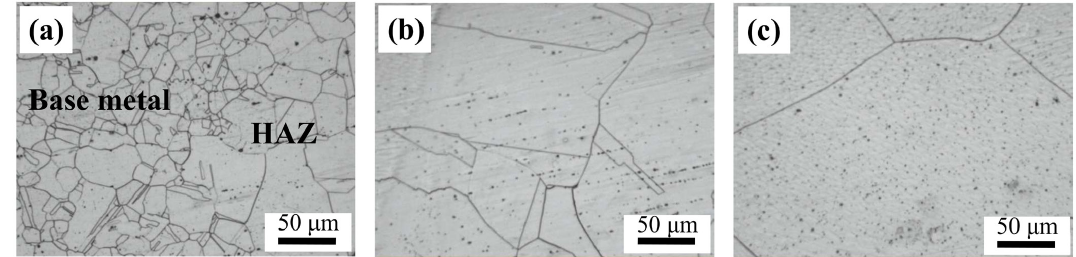
Figure 5. Microstructure in different regions of PAW joint (a)welded joint (b) heat affected zone(c)weld zone.